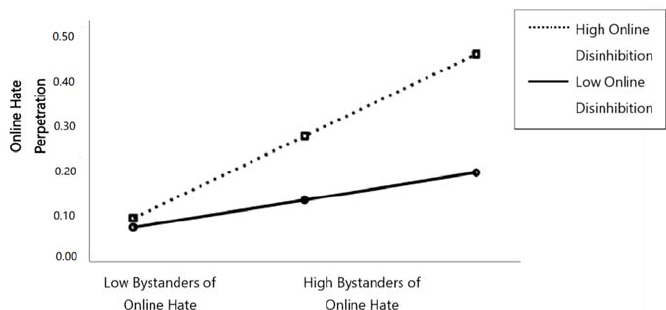
Figure 1. Simple slopes equations of the regression of online hate bystanders on online hate perpetrators at high and low levels of toxic online disinhibition.